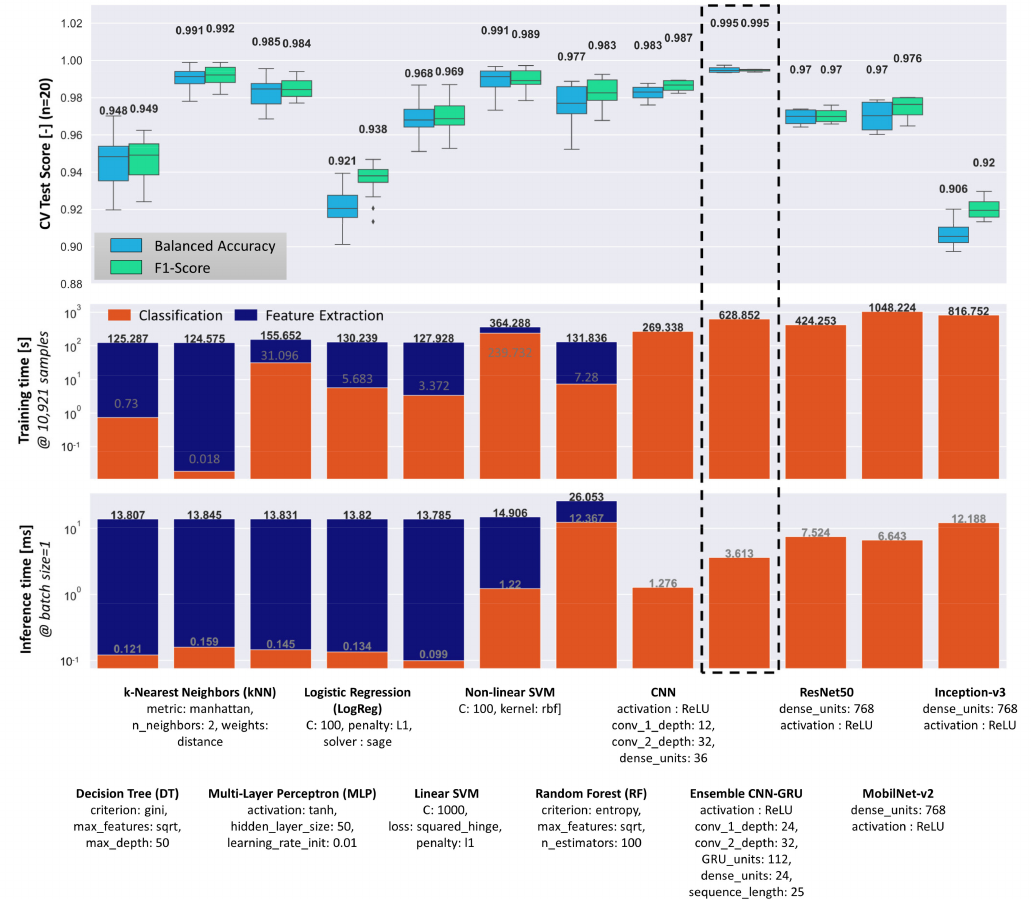
Figure 9. Performance comparison of different conventional machine learning and deep learning classification methods. Optimal hyperparameter for each classifier were found via grid search (Table A3). The median scores are displayed in the top